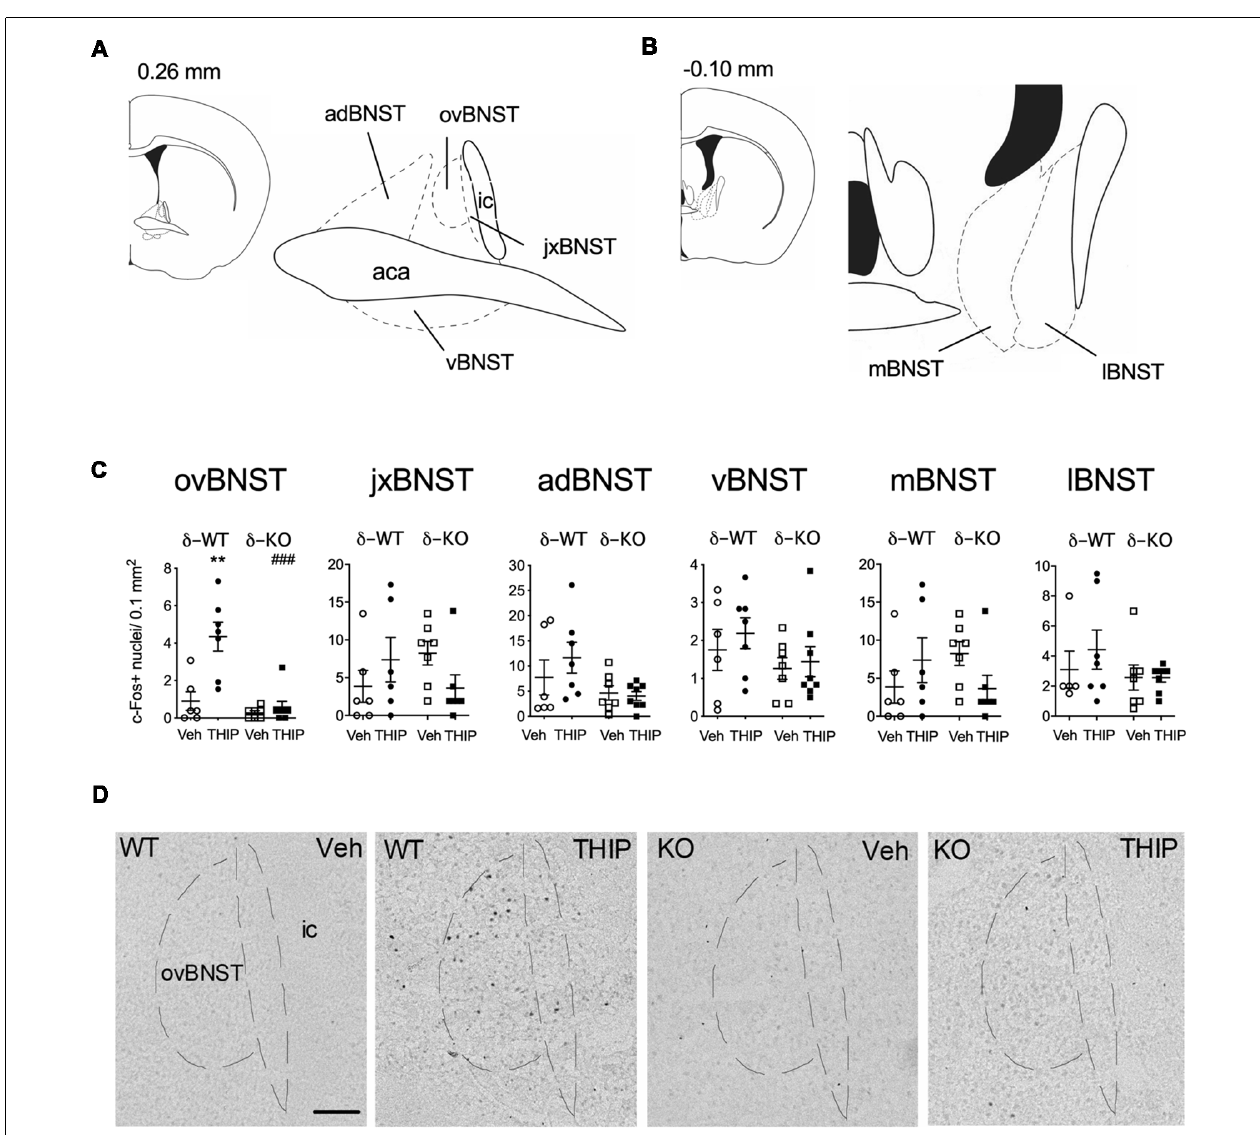
FIGURE 3 | THIP-induced c-Fos expression was detected specifically in the ovBNST in wild type littermates (WT), this effect being abolished in δ -KO mice. (A,B) Schematic diagrams of the brain sections (Franklin and Paxinos, 2008) showing levels of analyzed regions of the BNST. (C) Effects of THIP (6 mg/kg) and vehicle (Veh) treatments on the c-Fos expression 2 h after injection in subdivisions of the BNST of adult WT and δ -KO mice. Scatter plots with means ± SEM, n = 6–8 mice per group, ∗∗ p = 0.005 for the significance of difference from the corresponding vehicle treatment, and ### p < 0.001 from the corresponding WT value (Kruskal-Wallis with Mann-Whitney test). (D) Representative immunostaining of c-Fos after THIP and Veh in the ovBNST of WT and δ -KO mice. Scale bar = 100 µ m. ovBNST, oval BNST; jxBNST, juxtacapsular BNST; adBNST, anterodorsal BNST; vBNST, ventral BNST; mBNST, medial BNST; lBNST, lateral BNST; aca, anterior commissure; ic, internal